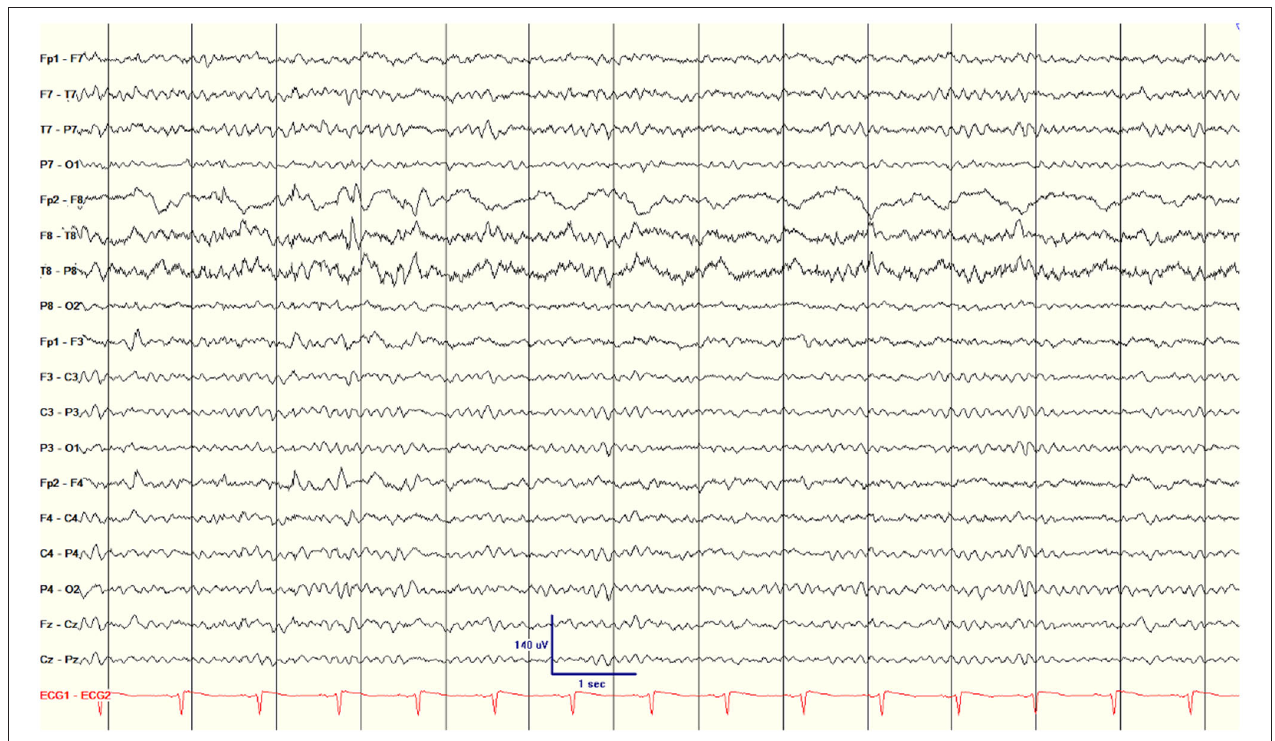
FIGURE 1 | Scalp EEG showing nearly continuous interictal regional slow activity (IRSA) on the surgical side (right hemisphere) in patient 2.